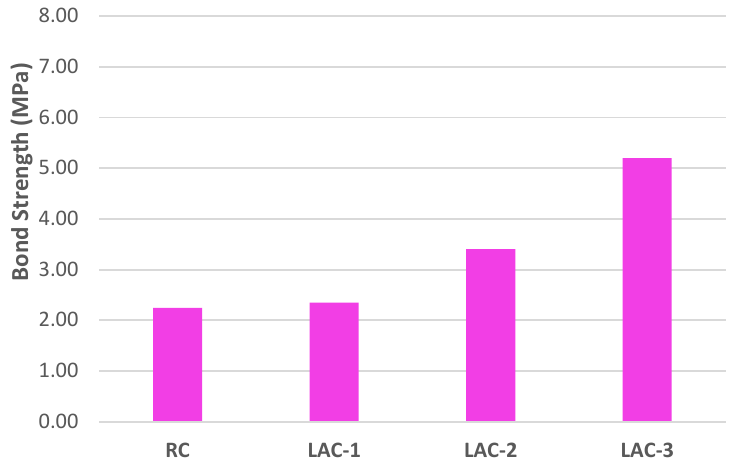
Figure 16. Bond strength test results of the mixes.